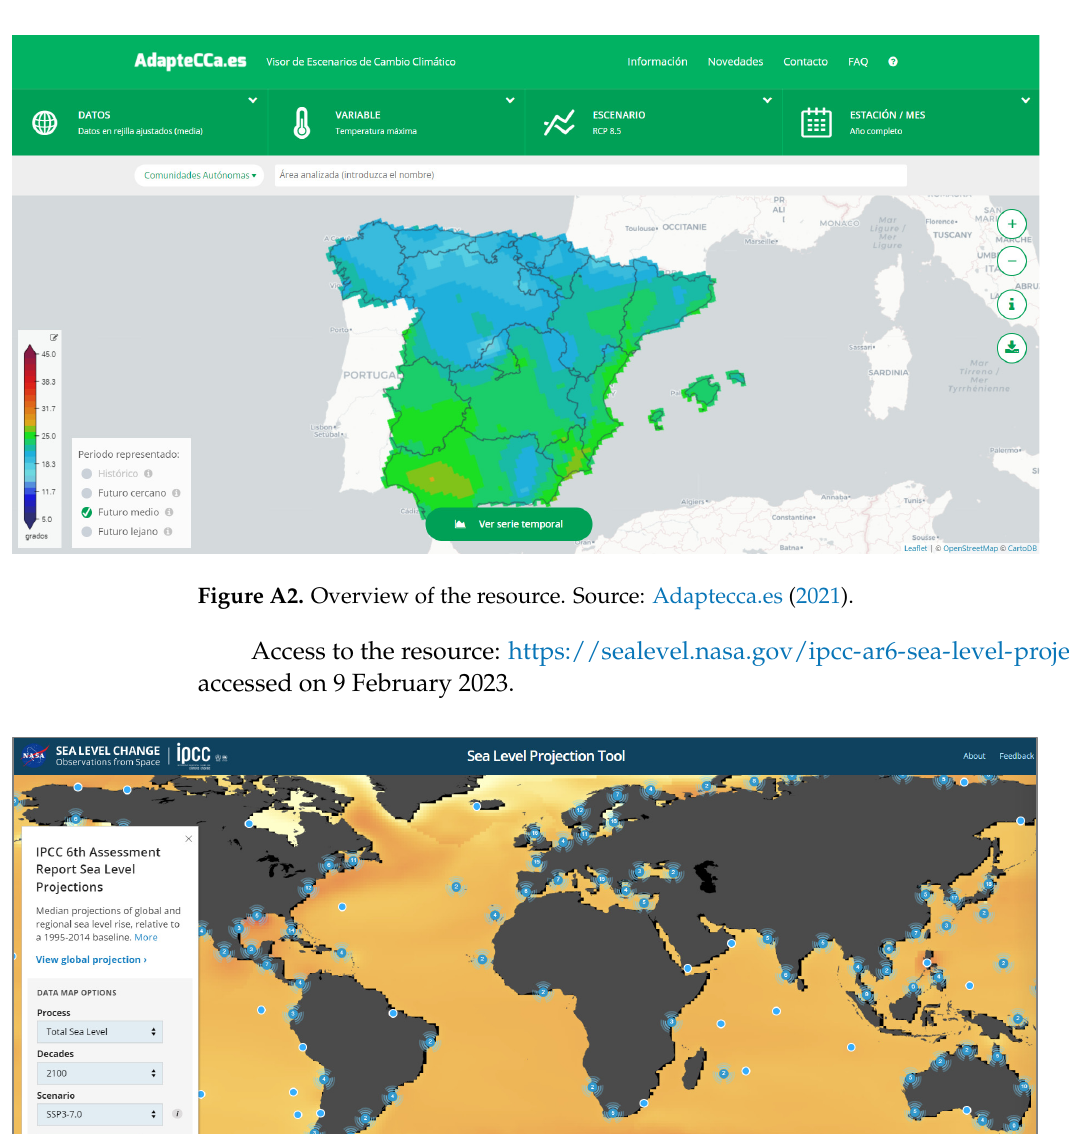
24 of 32 Figure A1. Overview of the resource. Source: Gutiérrez et al. (2021). Questions for reflection and reinforcement of concepts: a.